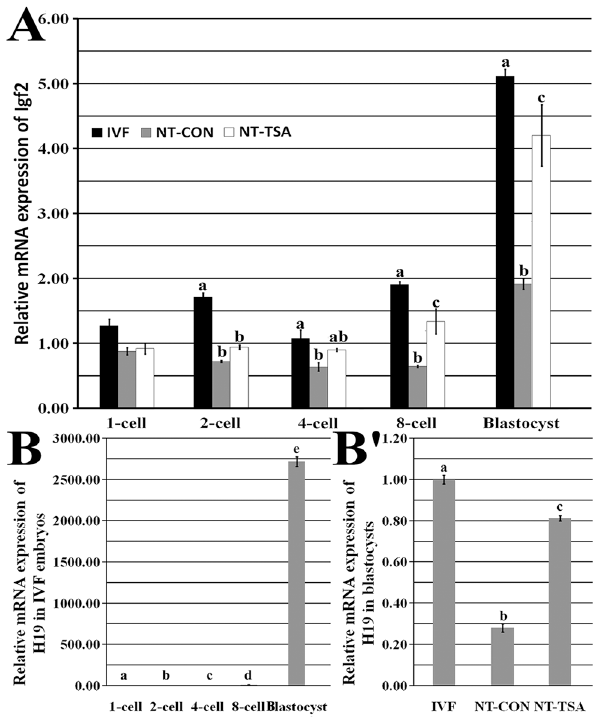
Fig 2. Relative H19/Igf2 transcripts in early embryos. A, relative Igf2 transcripts at 1-cell, 2-cell, 4-cell, 8-cell and blastocyst stages of IVF, NT-CON and NT-TSA embryos, B, H19 transcripts in IVF embryos, and B', H19 transcripts in blastocysts of IVF, NT-CON and NT-TSA embryos. TSA improved the expression levels of H19/Igf2 in cloned embryos. The transcript abundance in MII stage oocytes (A and B) or IVF blastocysts (B') was considered to be the control. The data were expressed as mean ± SEM. a-e Values with different superscripts differ significantly (P < 0.05).